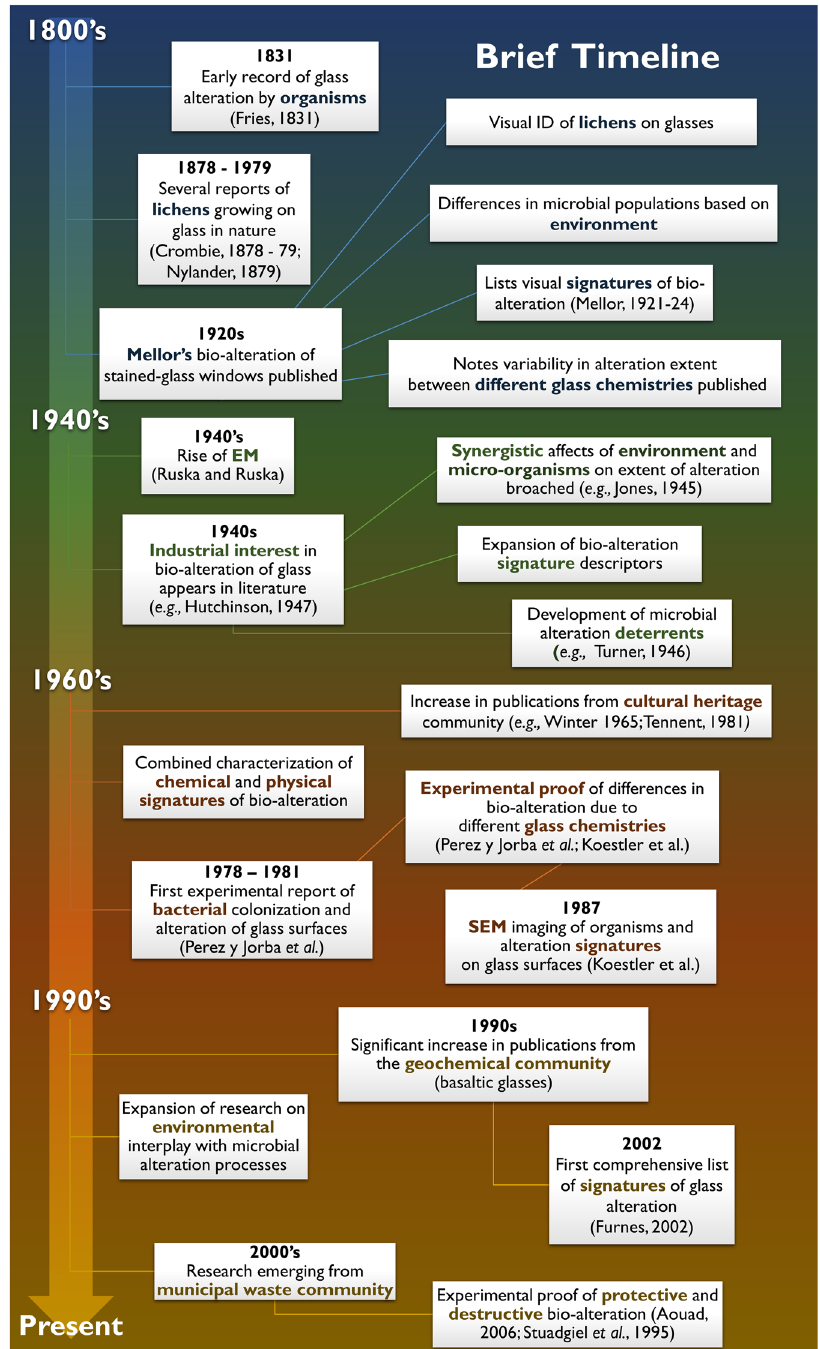
Fig. 1 Brief historical outline on the development of glass bio-alteration research from the 1800 ’ s to present time. Colored lines indicate events/developments that occurred in a set time period. Connections were assigned based on citations and/or listing of connections in public